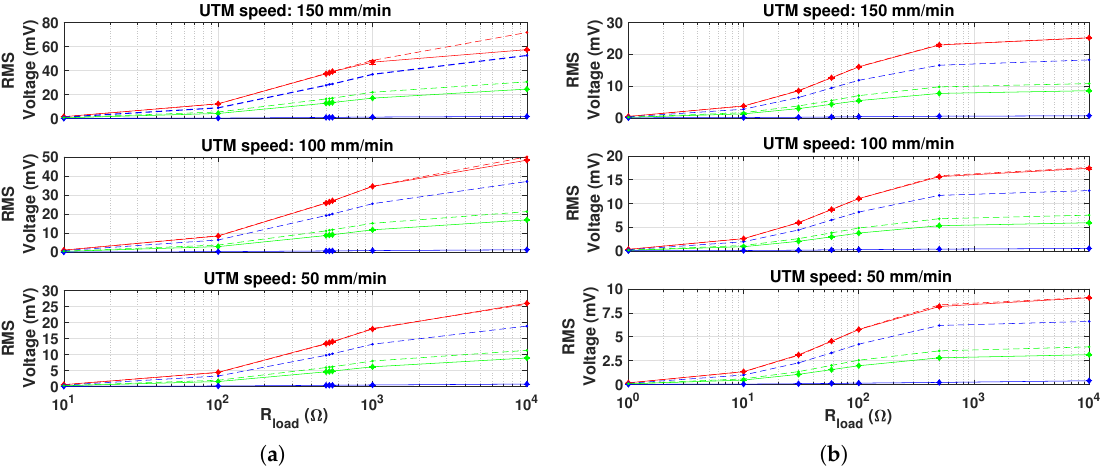
Figure 12. Comparison between the RMS measured (diamonds with solid line) and simulated (dots with dashed line) voltage vs. the applied electric load. PMs with different diameters are considered—10 (green), 15 (red) and 20 mm (blue). ( a ) Coils connected in series. ( b ) Coils connected in